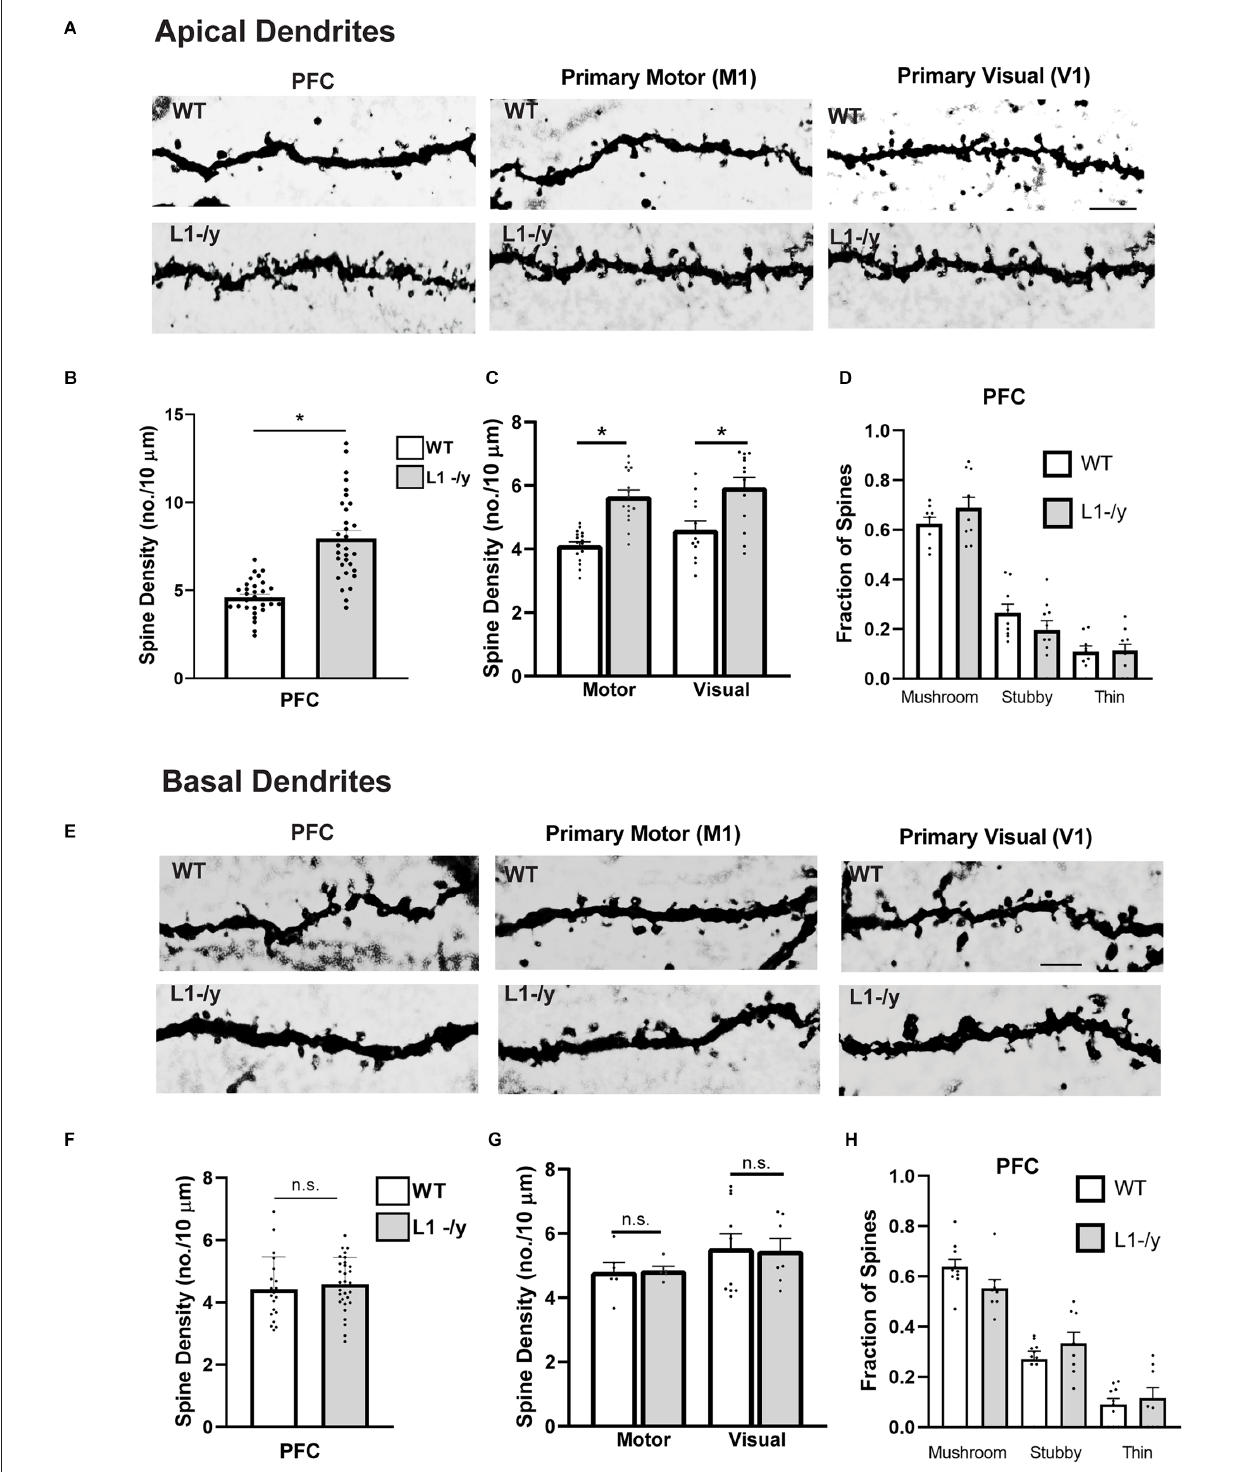
FIGURE1 L1-/y null mutant mice display increased spine density on apical dendrites of cortical pyramidal neurons. (A) Representative images of apical dendrites of Golgi-labeled pyramidal neurons in PFC layer 2/3 (primary cingulate), the primary motor cortex (M1, layer 5), and primary visual cortex (V1, layer 4) in WT or L1-/y mice. Scale bar = 5 µ m for all images. (B,C) Mean spine densities of pyramidal neurons on apical dendrites of L1-/y PFC, M1, and V1 were significantly increased compared to WT ( n = 27–31 neurons/mouse; six mutant and six WT mice. Mean spine density in L1-/y PFC (8.0 spines/10 µ m ± 0.4) was significantly greater than in WT PFC (4.6 spines/10 µ m ± 0.2; *Mann-Whitney 2-tailed test, p = 0.03). Mean spine density in L1-/y M1 (5.6 spines/10 µ m ± 0.2) was significantly greater than in WT M1 (4.1 spines/10 µ m ± 0.1; * p < 0.001). Mean spine density in L1-/y V1 (5.9 ± 0.3) was also significantly greater than in WT V1 (4.6 spines/10 µ m ± 0.3 * p = 0.003). Each point